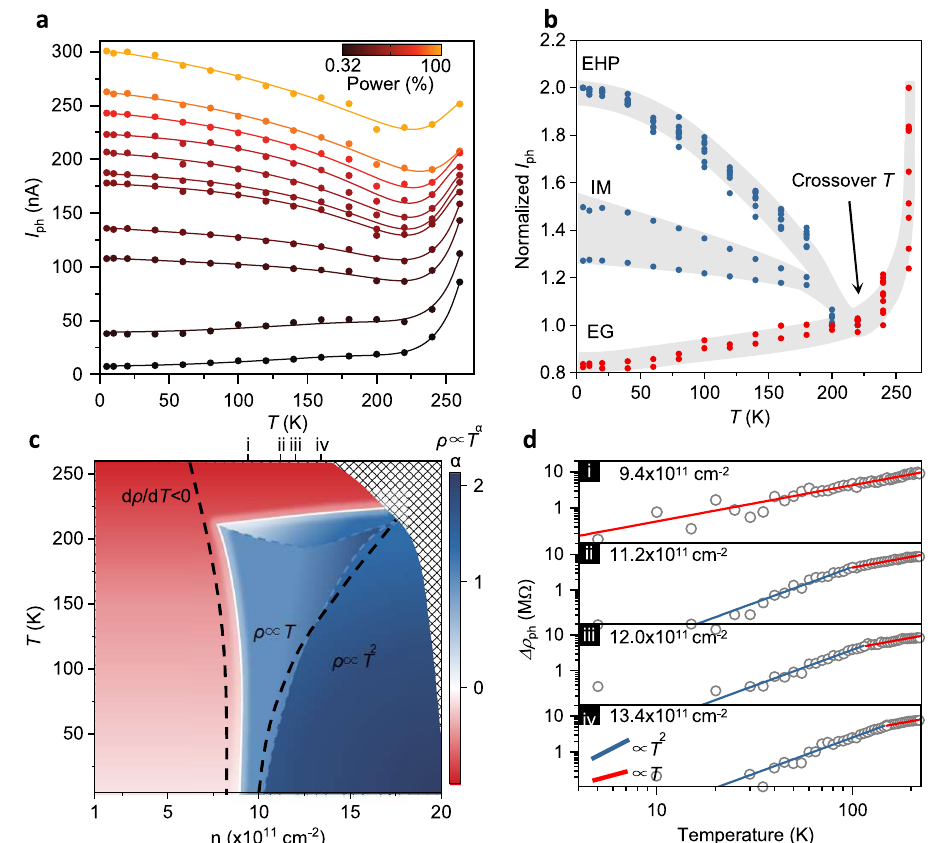
Fig.4|ContinuousexcitonMotttransitioninBP.a Temperaturedependenceof integrated photocurrent at different excitation powers. 100% P =160W/cm 2 . b Photocurrents in a normalized to the maximum value at each excitation power. The curves are vertically offset to align the value at EG crossover tem- perature (220K, indicated by black arrow) for clarity. The curves display three different branches, showing unconventional metallic properties near the transition boundary. c Phase diagram described in terms of the exponent of T - dependentresistivityextractedfromourtransportmeasurementsasafunction of T and pair density. The diagram clearly features a transition between the insulatingphasewithanegativecoef fi cient(red)and themetallicphaseswitha